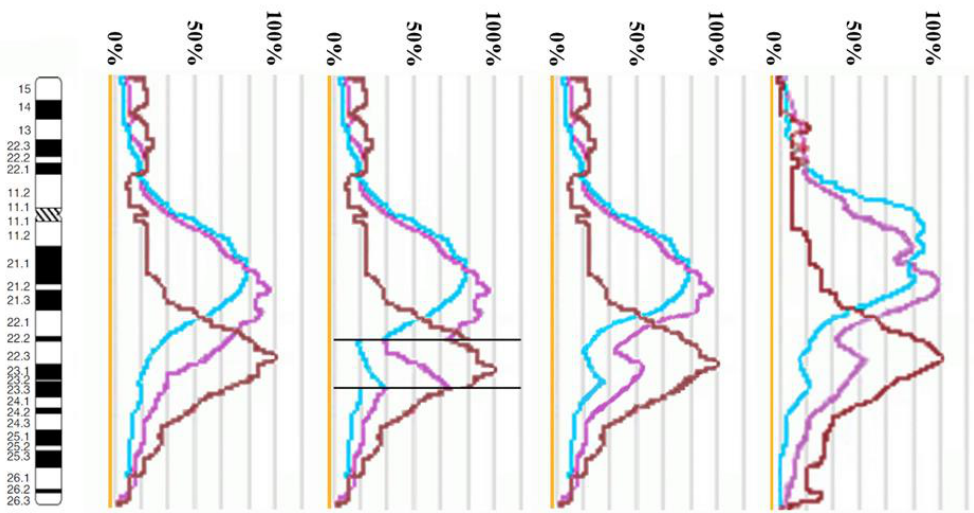
Figure 6. The scheme of hypothetical breakpoints of the inversion in 10q22.2 → q23.3 bands, as proposed on the basis of GTG-banding analysis.